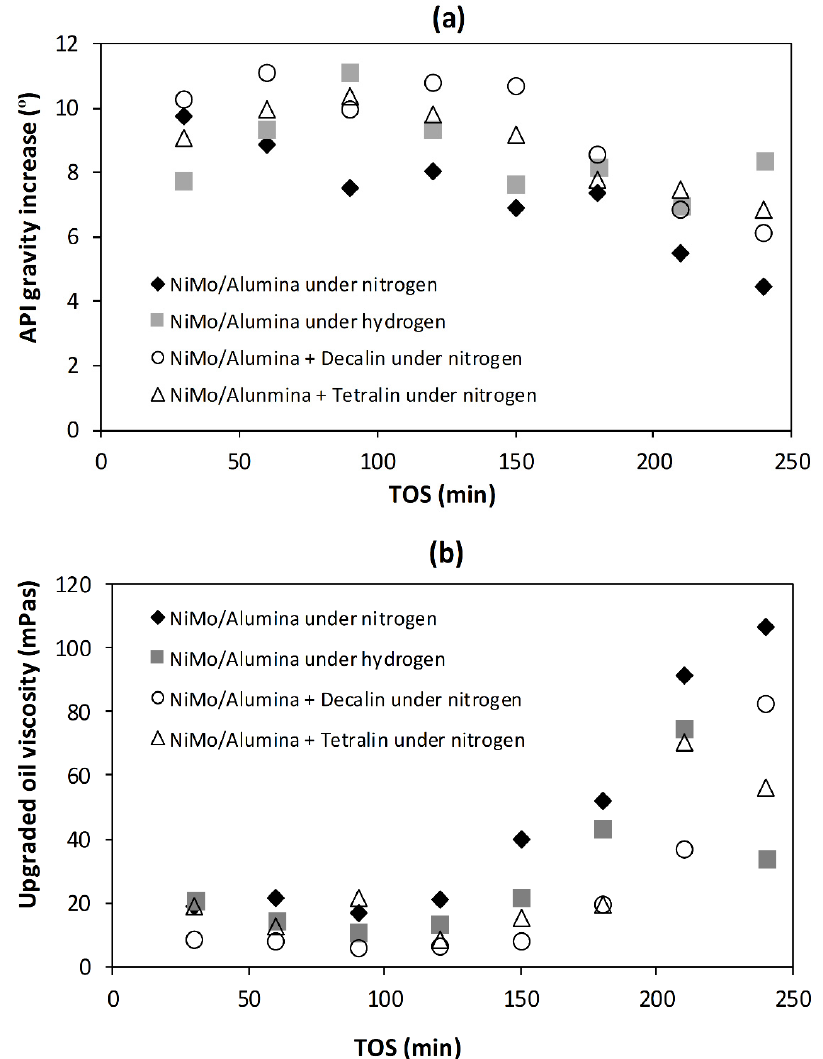
Figure 2. Upgraded oil with time-on-stream (TOS); ( a ) American Petroleum Institute (API) gravity increase (respective standard deviation: N 2 gas (±0.86°), H 2 gas (±0.60°), tetralin (±0.89°) and decalin (±1.2°)) and ( b ) viscosity (respective standard deviation: N 2 gas (±5.7 mPas), H 2 gas (±4.8 mPas), tetralin (±2.4 mPas) and decalin (±3.2 mPas)).